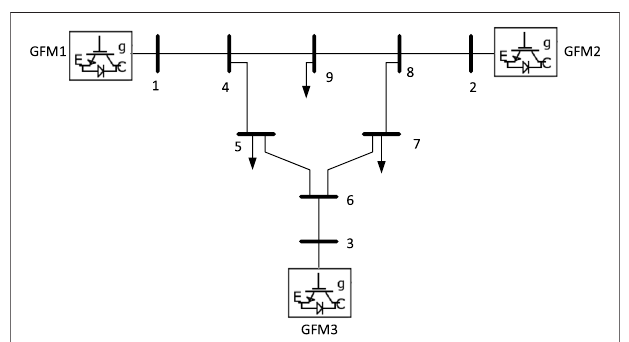
FIGURE 2 | Topology of a modi fi ed IEEE 9 bus test system with three GFM inverters.